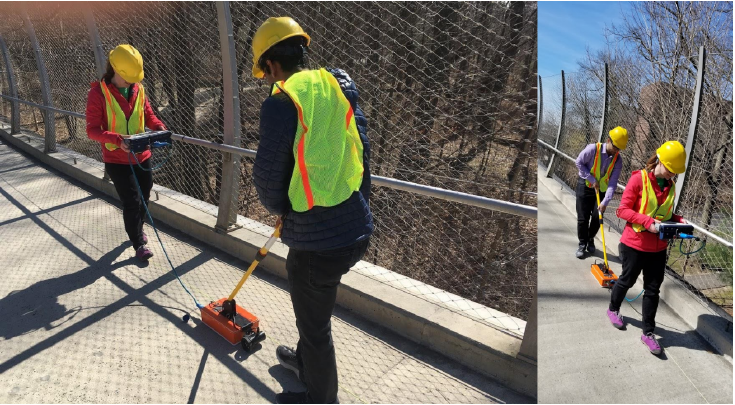
Figure 6. GPR data collection on Streicker bridge by the authors.